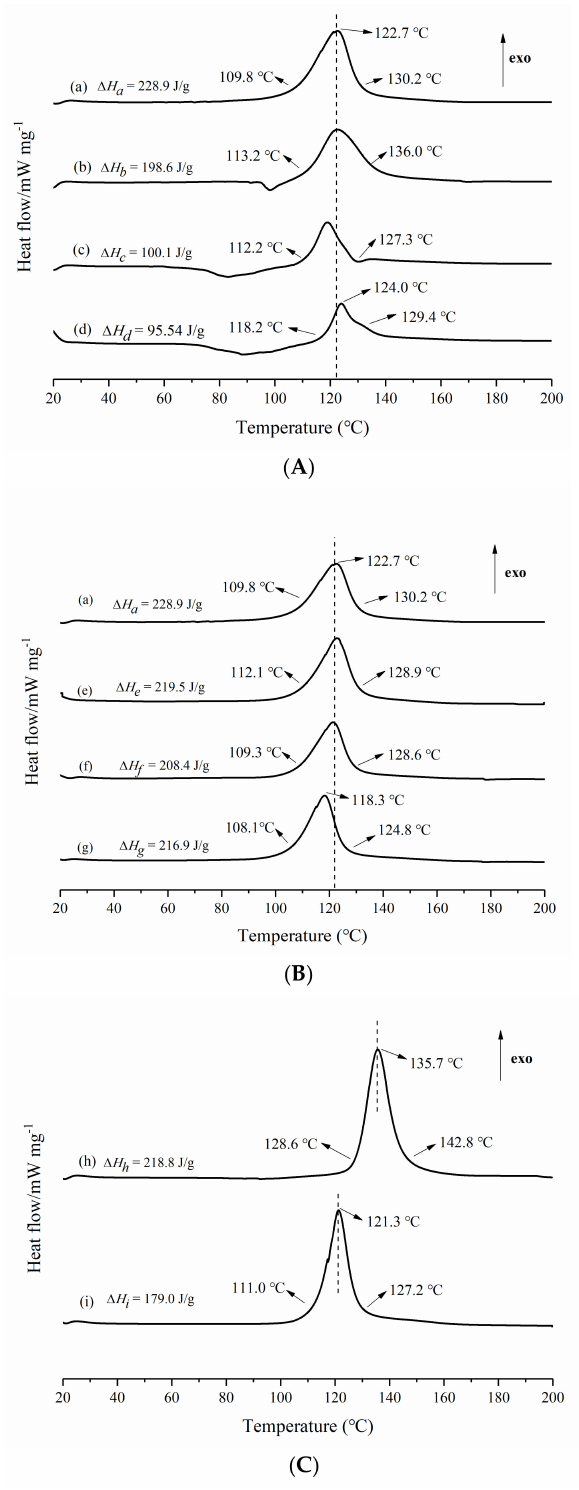
Figure 6. Non-isothermal differential scanning calorimetry curves of ( A ) wherein (a) pure UPR, (b) UPR + 1.00 phr NH 4 HCO 3 , (c) UPR + 2.00 phr NH 4 HCO 3 , (d) UPR + 3.00 phr NH 4 HCO 3 ; ( B ) wherein (a) pure UPR, (e) UPR + 1.00 phr chopped carbon fibers, (f) UPR + 3.00 phr chopped carbon fibers, (g) UPR + 5.00 phr chopped carbon fibers; ( C ) wherein (h) UPR (accelerator-free) + 2.00 phr NH 4 HCO 3 + 4.00 phr chopped carbon fibers, (i) UPR + 2.00 phr NH 4 HCO 3 + 4.00 phr chopped carbon